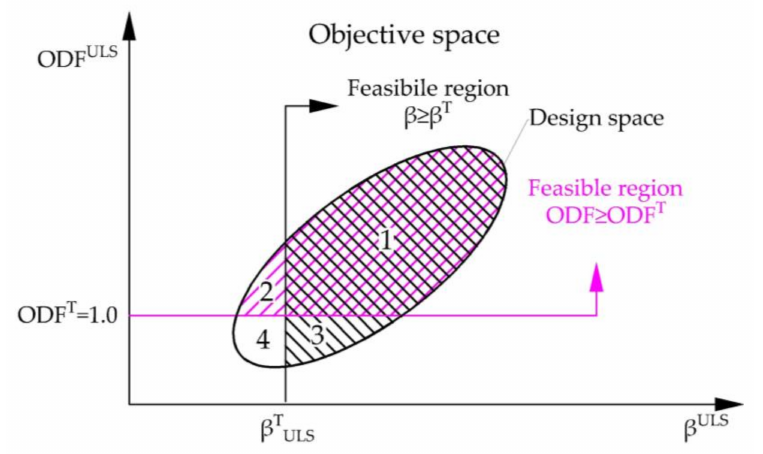
Figure 2. A schematic illustration of the existing and the suggested ULS feasible